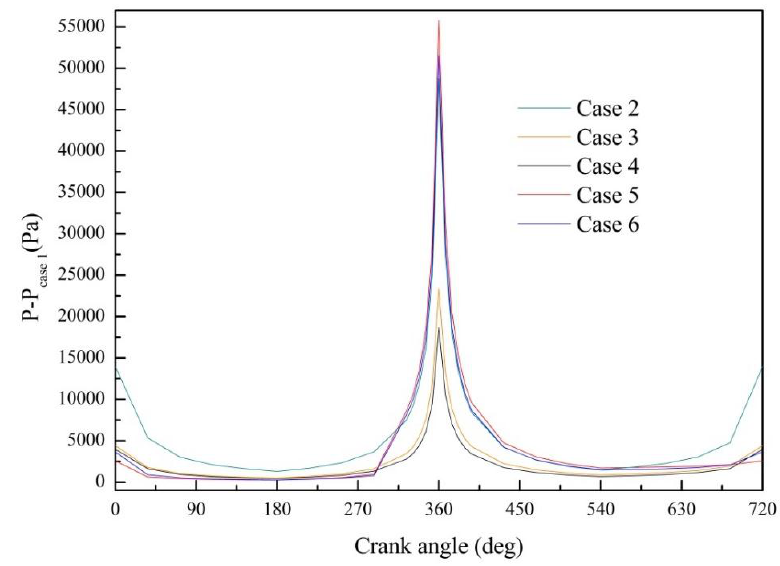
Figure 13. The difference of cylinder gas pressure under different coolant conditions.